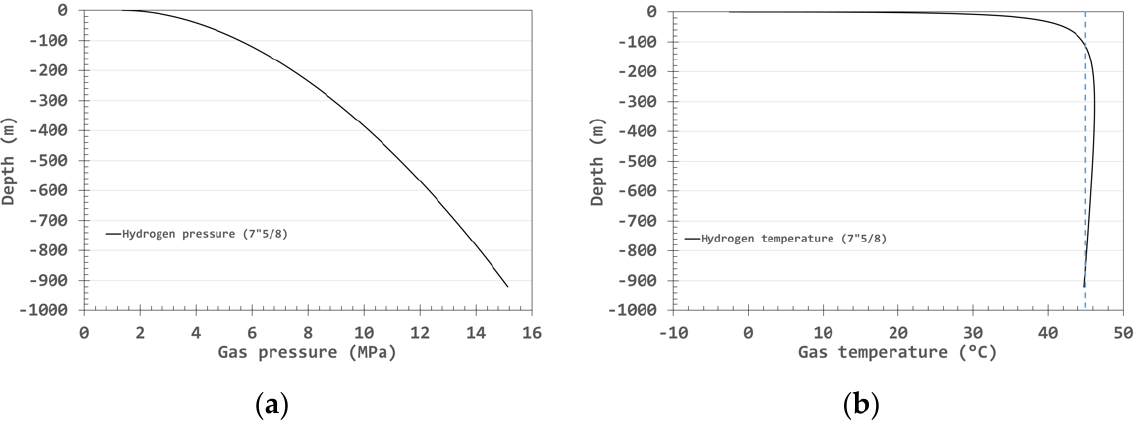
Figure 4. Distribution of: ( a ) Pressure; ( b ) hydrogen temperature, as a function of depth at the start of the blowout ( t =